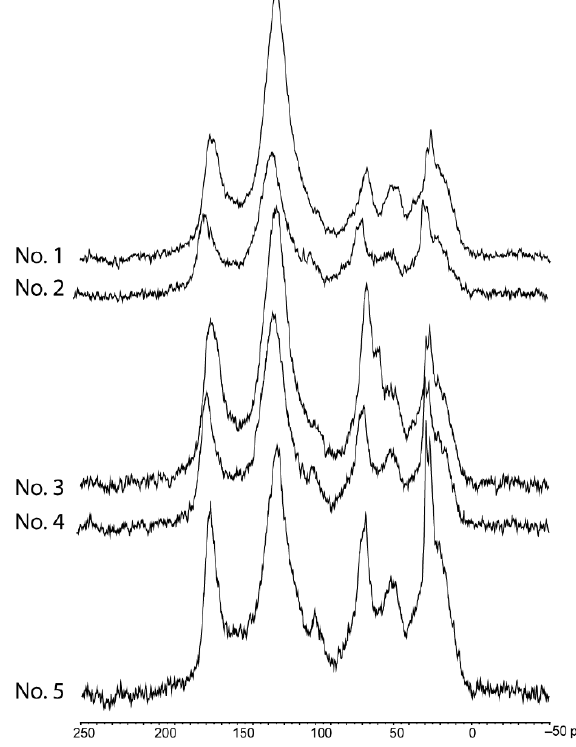
Figure 4. 13 C CP/MAS-NMR spectroscopy of HAs extracted from: arable non-eroded chernozem (Nos. 1, 2), arable eroded chernozem (Nos. 3, 4), forest windbreak chernozem (No. 5). X-axis — chemical shifts, ppm.